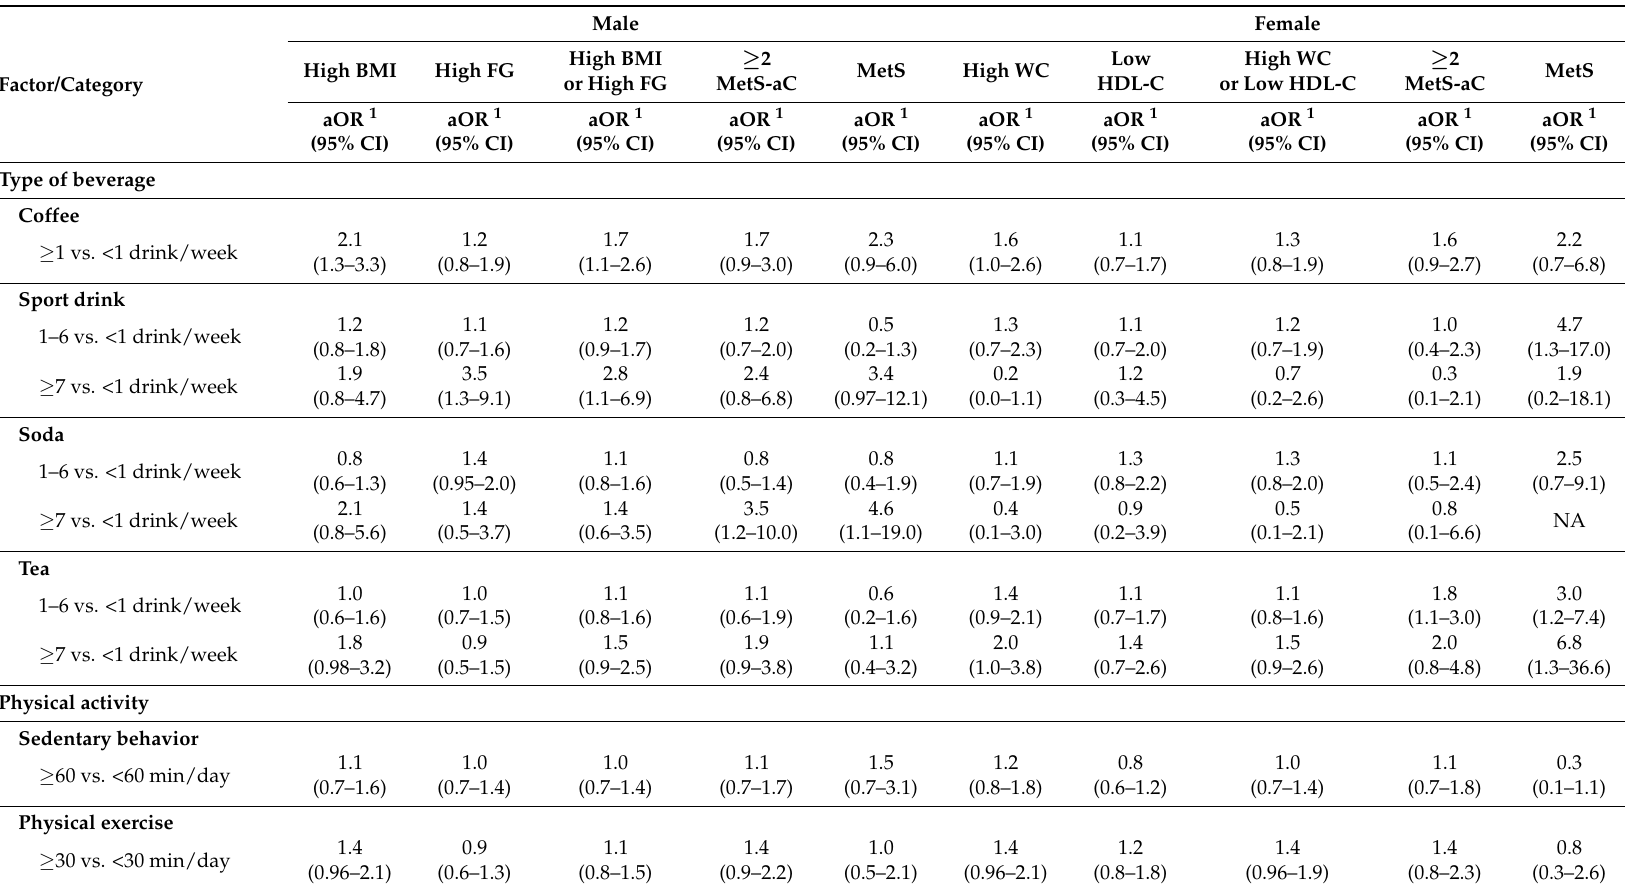
Table 5. Adjusted odds ratio (aOR) of the clustering of MetS risk components associated with beverage consumption and physical activity in adolescents, Taiwan.